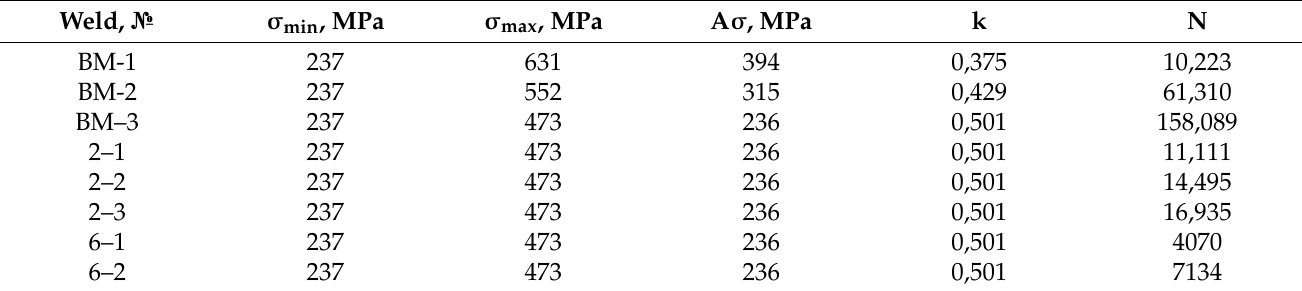
Table 7. Fatigue test parameters.